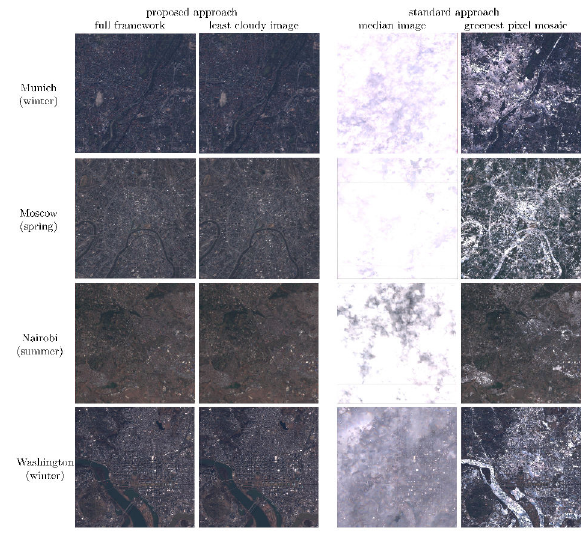
Figure 9. Cloud-free image aggregation examples for areas moderately affected by